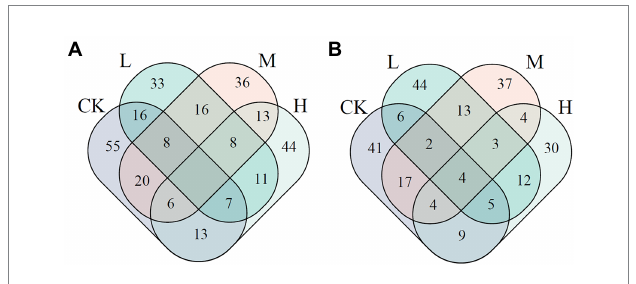
FIGURE 2 Venn diagram of keystone nodes in each network in JSJ (A) and LF (B) soils.